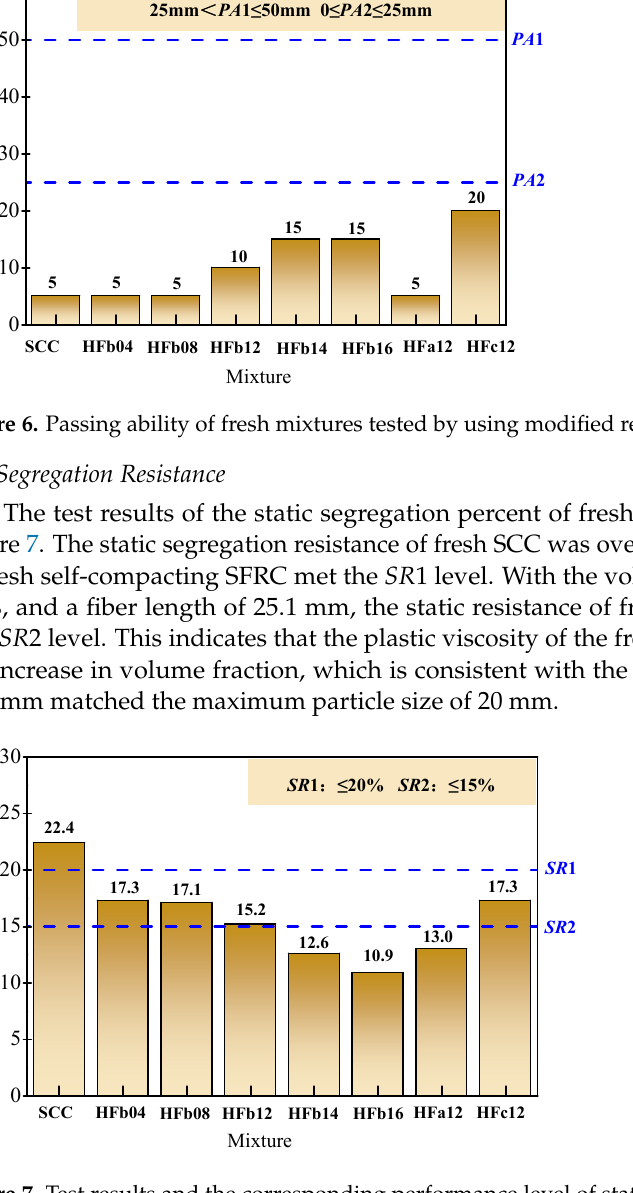
Figure 5. Test results and the corresponding performance level of passing ability. ( a ) J-ring flow. ( b ) PA.